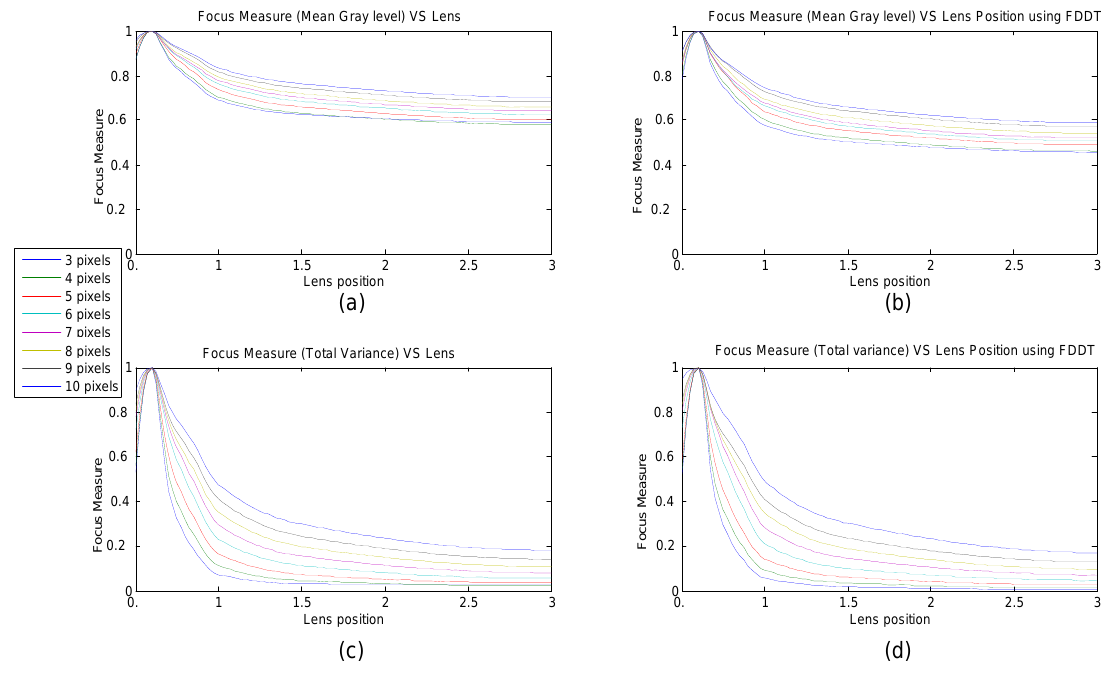
Figure 5. Focus measures for different optic focus position and methods. (a) gl